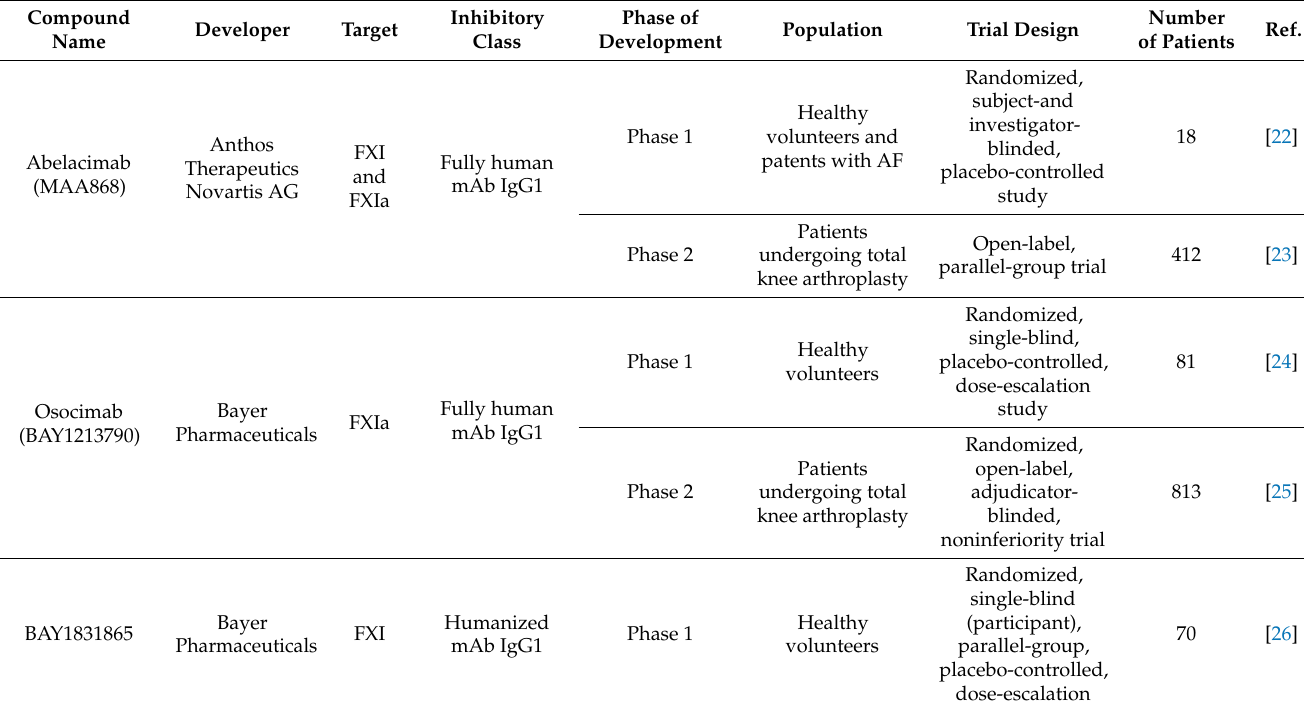
Table 2. FXI inhibitors currently under clinical development for the treatment of TEV and